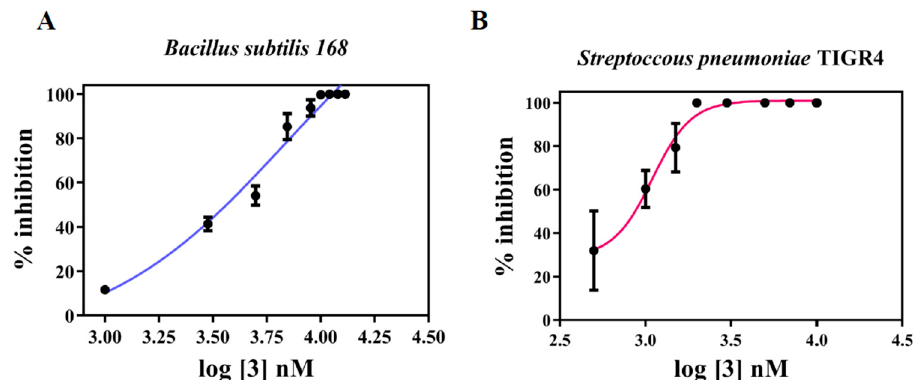
Figure 3. Compound 3 shows strong anti-bacterial activity. The percentage inhibition of proliferation was plotted against the log concentration of reduced enol 3 against ( A ) Bacillus subtilis 168, ( B ) Streptococcus pneumoniae TIGR4. Error bars represent the standard deviation from three independent sets of experiments.